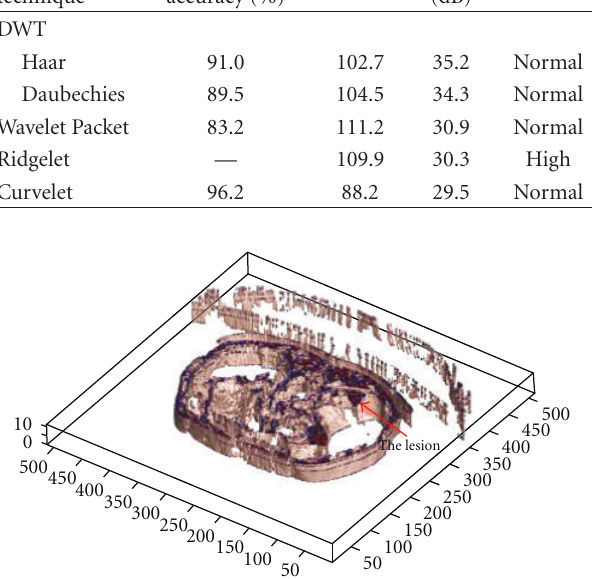
Figure 23: Segmenting patient volume data a ff ected by the kidney